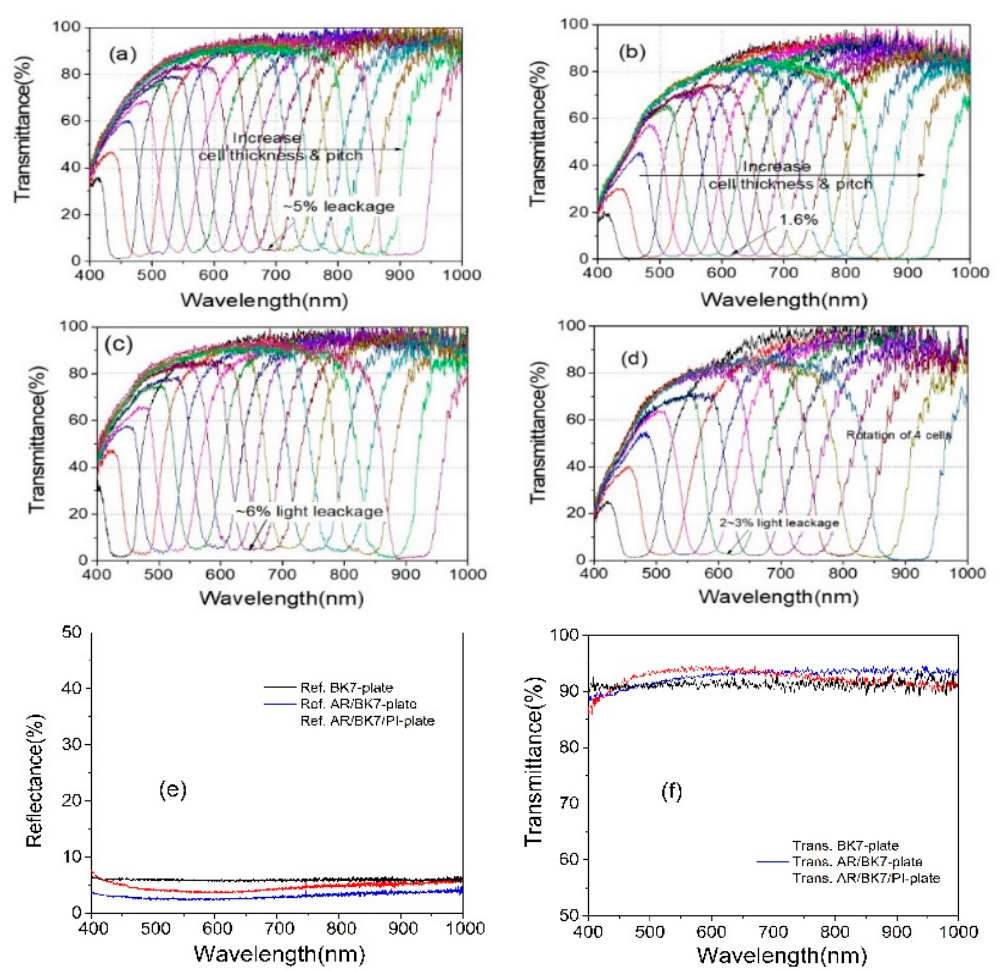
Figure 6 shows continuous tuning PBG spectra of CLC notch filter systems with pitch gradients.